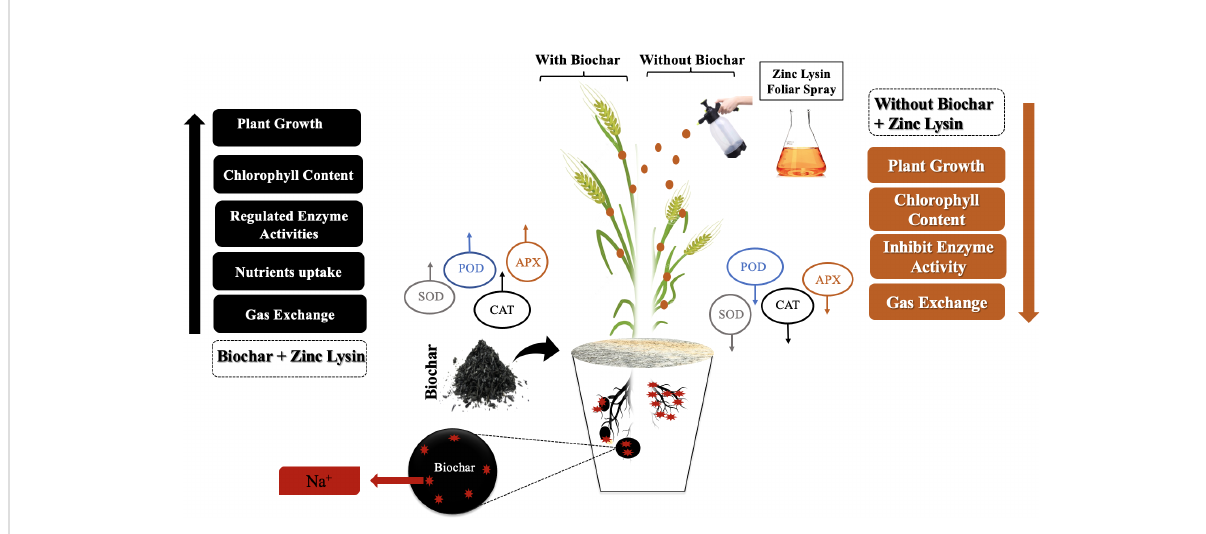
FIGURE 1 Data represent different levels of zinc – lysine (control 0, 1, 2 mM) with and without biochar on chlorophyll a, chlorophyll b, total chlorophyll, carotenoid, Pn , gs , Tr , and WUE contents of wheat plant showing means of replicates (n = 3) ± standard deviation. Different letters indicate signi fi cant differences by Tukey HSD test at p ≤ 0.05.